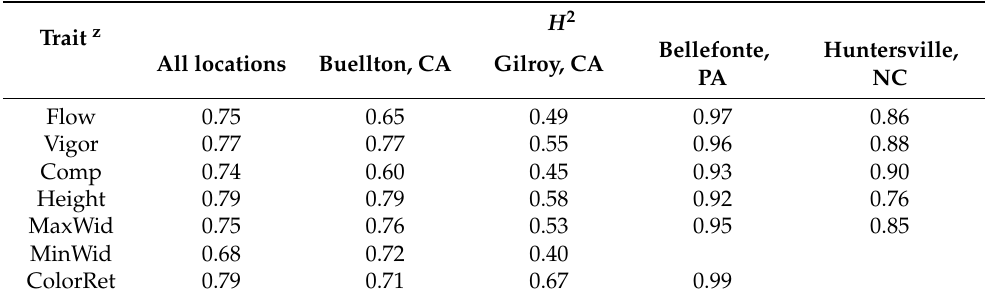
Table 4. Broad-sense heritability ( H 2 ) estimates growth and flowering traits of a P. axillaris × P. exserta F 7 recombinant inbred line population at four